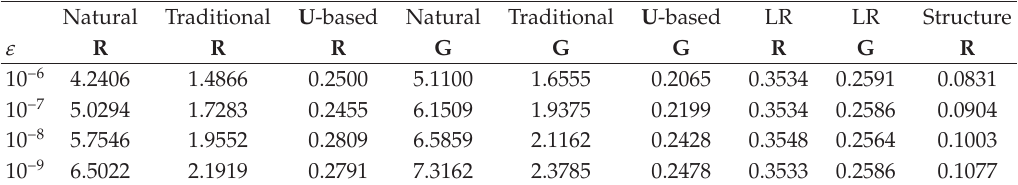
Table 4: Time in seconds required for di ff erent methods to execute for interarrival times having probability